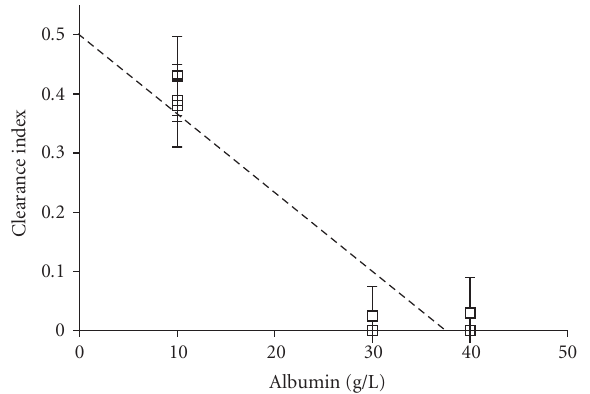
Figure 1: Variation of clearance index of lopinavir at di ff erent albumin perfused concentrations (for 10g/L n = 3, for 30 g/L n = 3 and for 40g/L n = 5). Linear regression ( r 2 = 0 . 886).